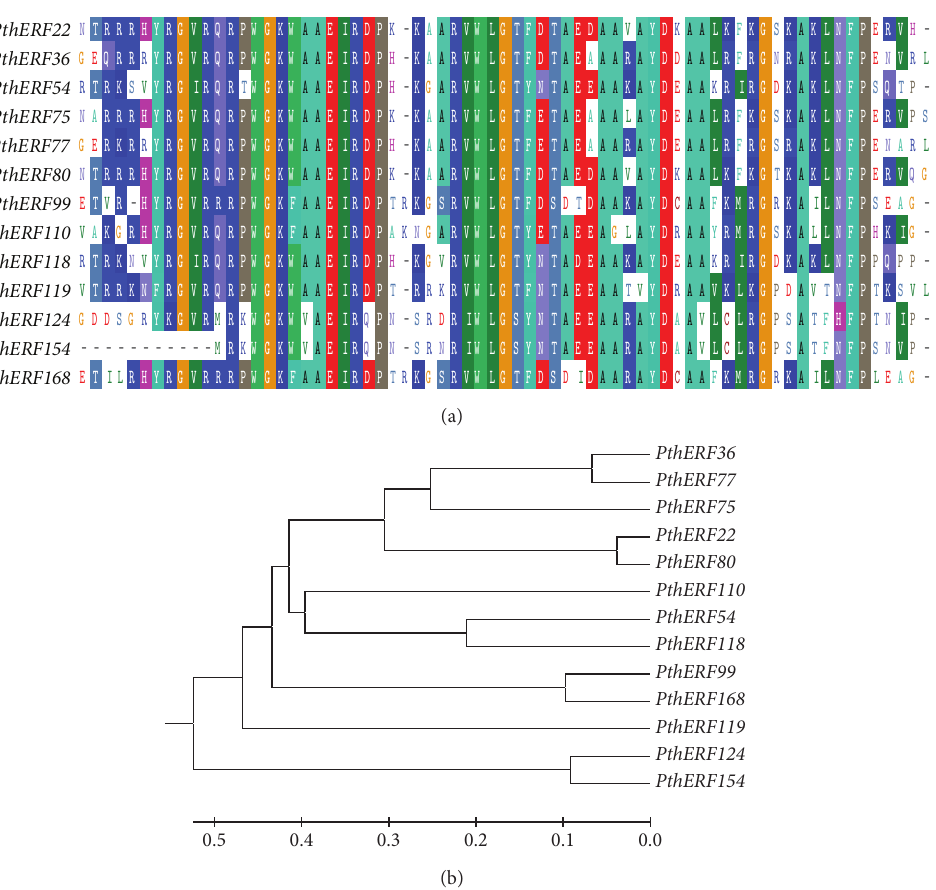
Figure 2: Multiple alignments and phylogenetic analysis of the amino acid sequence of thirteen PthERFs . (a) Multiple sequence alignments of 13 PthERFs with ERF domain sequences. (b) Phylogenetic analysis of 13 PthERFs based on amino acid sequences.